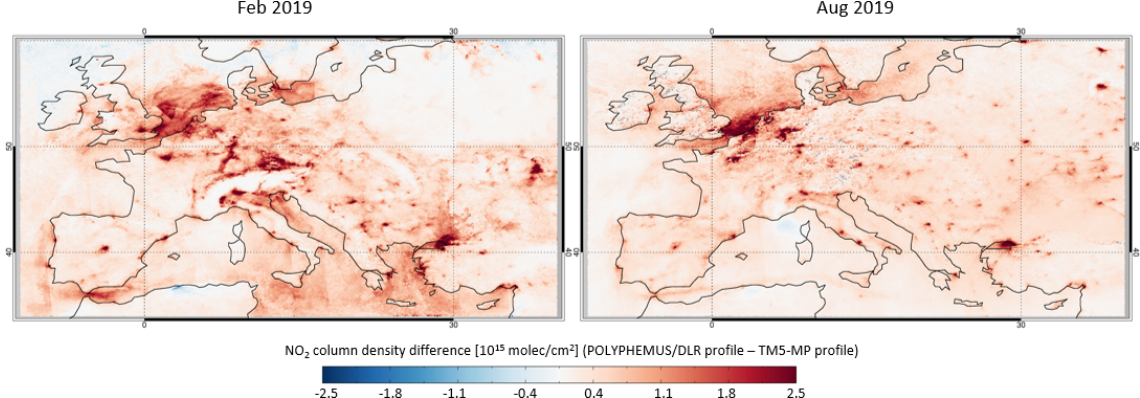
Figure 10. Differences in the tropospheric NO 2 columns retrieved using the TM5-MP and POLYPHEMUS/DLR a priori NO 2 profiles over Europe in February and August 2019. Only measurements with a cloud radiance fraction less than 0.5 are included.